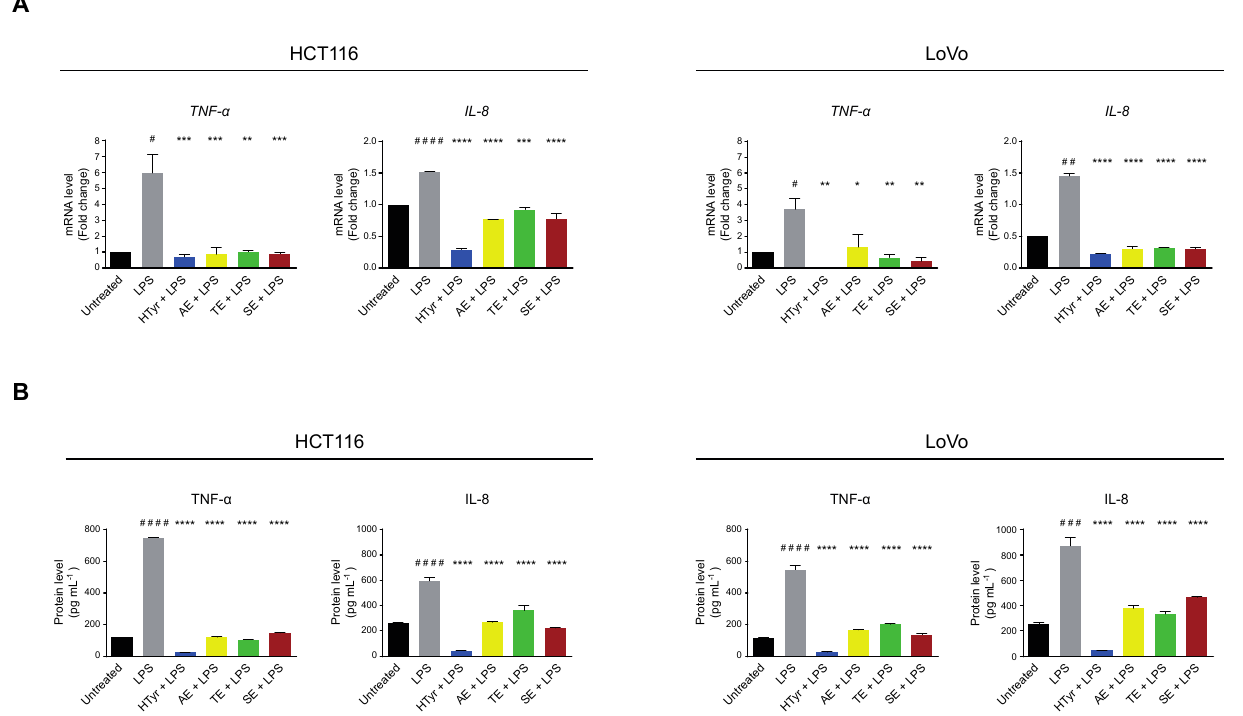
Figure 7. Hydroxytyrosol and OPWPs extracts prevent inflammation in HCT116 and LoVo cells. ( A ) qRT-PCR analysis of TNF- α and IL-8 mRNAs in HCT116 (left) and LoVo cells (right) treated with HTyr or OPWPs extracts for 72 h and LPS for the last 10 h. ( B ) ELISA assay for TNF- α and IL-8 protein levels in the culture medium of HCT116 (left) and LoVo cells (right) treated as in ( A ). Statistical significance is considered when # p ≤ 0.05, ## p ≤ 0.01, ### p ≤ 0.001, #### p ≤ 0.0001 ( t -test) or * p ≤ 0.05, ** p ≤ 0.01, *** p ≤ 0.001, **** p ≤ 0.0001 (ANOVA with Dunnett’s post-test).